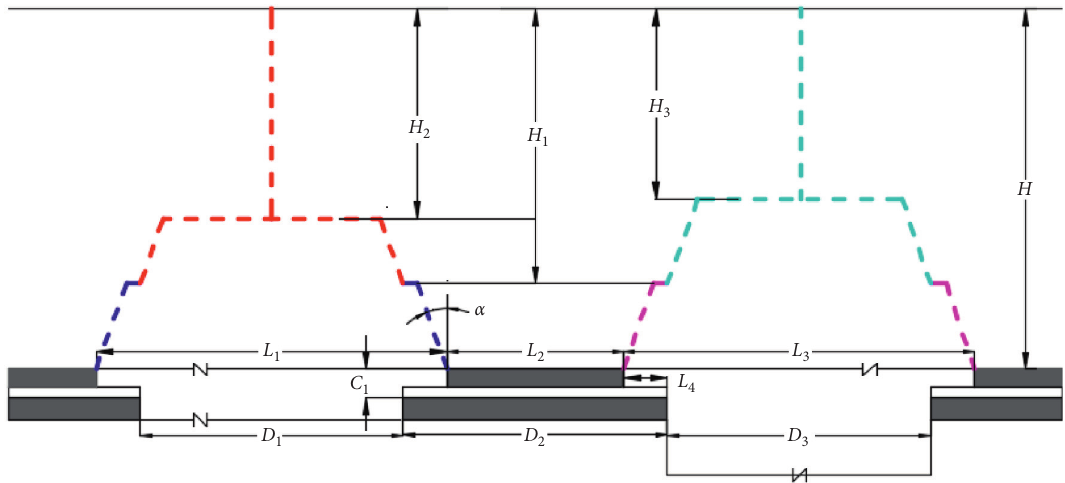
Figure 6: A mechanical model of the load of an extremely close stepped coal pillar.